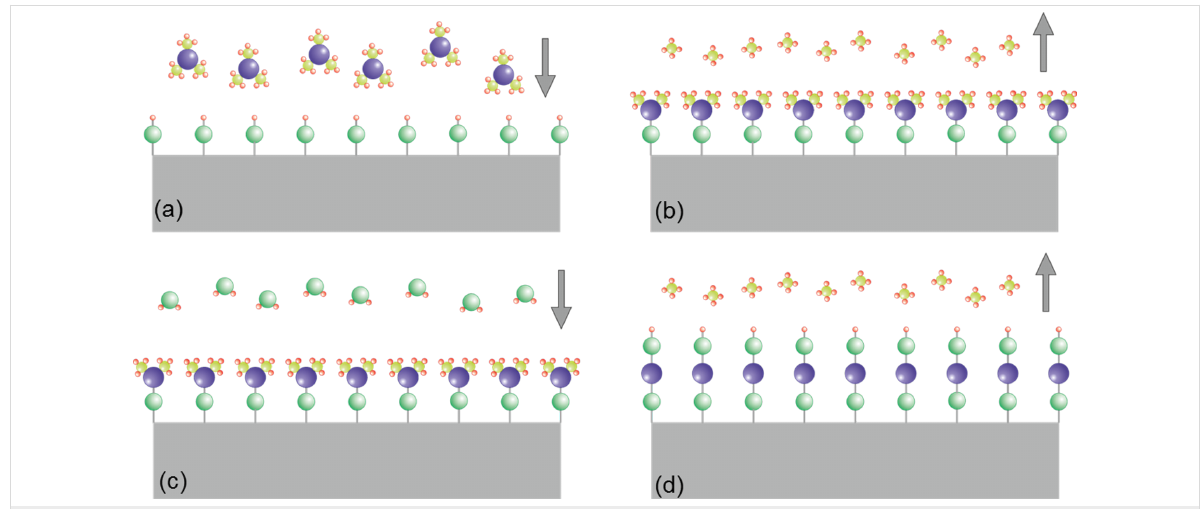
Figure 2: A schematic illustration of one cycle in ALD: (a) The first precursor flows into the chamber and reacts on the active sites of the substrate by partially losing ligands. (b) One mono-layer of reactant is formed and the chamber is purged to remove the remaining precursor and the intermediate product. (c) The second precursor is then introduced into the chamber to react with the remaining ligands and to form the desired compound mole- cule. (d) One cycle is complete when all of the ligands of the first precursor are consumed and one mono-layer of the compound is formed. The chamber is purged again for next cycle.